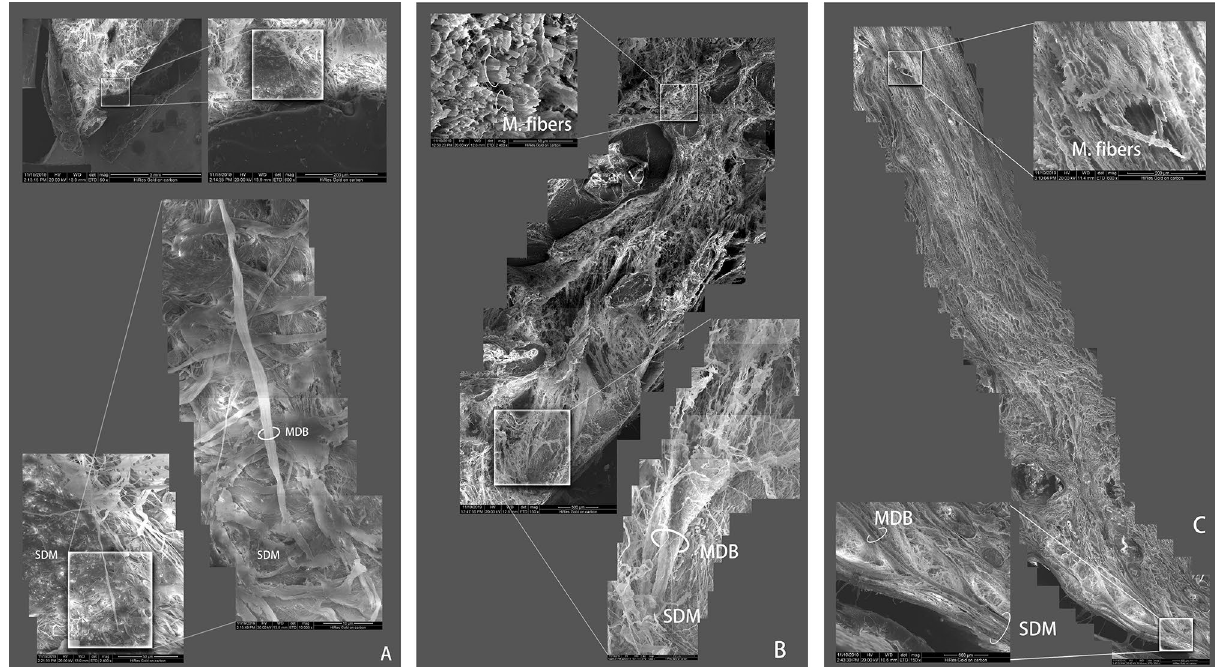
Figure 6. Scanning electron microscopic observation of the occipital-dural muscle and the spinal dura mater of N.asiaeorientalis in the atlanto-occipital interspace. ( A , B ) connection between the MDB and the SDM. ( C ) sagittal view of a tissue block. MDB: myodural bridge. SDM: spinal dura mater. M. fibers: muscular fibers of the occipital-dural